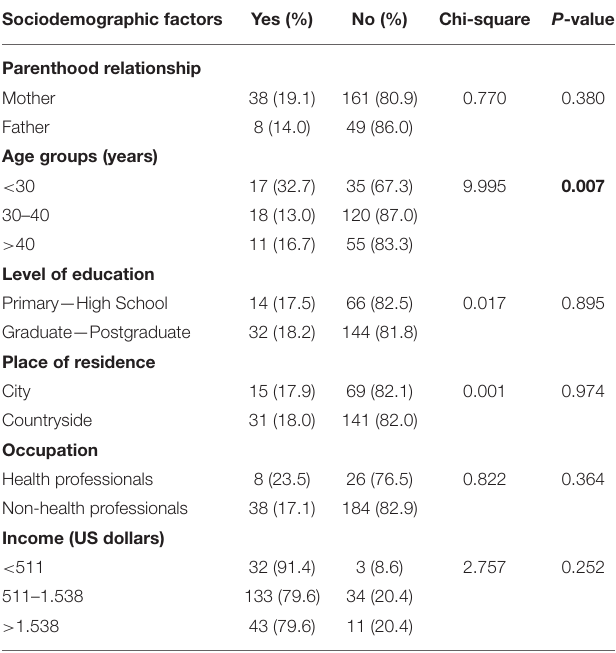
TABLE 8 | Response of parents regarding whether they took any additional precautions for their children during the COVID-19 pandemic.